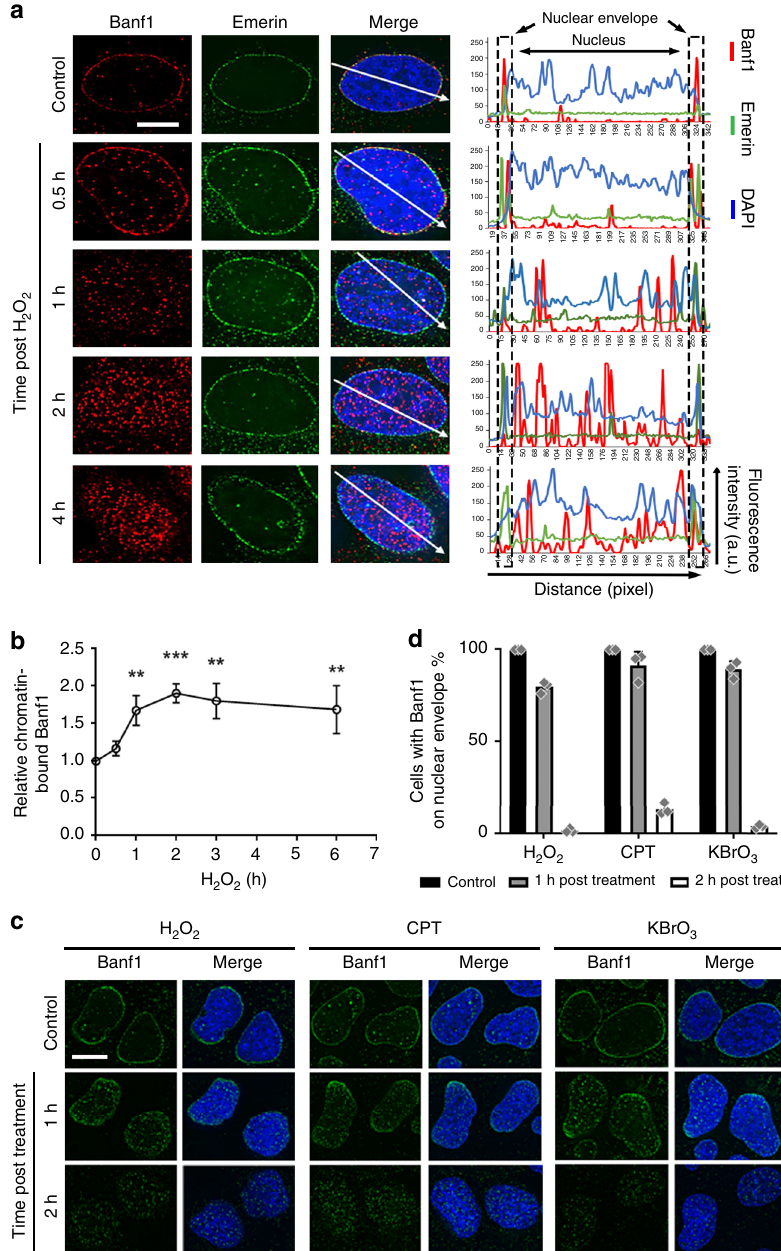
Fig. 1 Banf1 responds to oxidative stress. a Banf1 relocalises from the nuclear envelope following oxidative stress induced by 200 μ M H 2 O 2 in U2OS cells. Representative cells are shown. b The nuclear intensity of Banf1 in U2OS cells treated as in ( a ), were analysed via an InCell Analyser 2200. One-way ANOVA was used for statistical analysis. c Banf1 relocalisation following hydrogen peroxide (H 2 O 2 ), camptothecin (CPT), or potassium bromate (KBrO 3 ) at the indicated times post compound removal. Representative cells stained with the indicated antibodies are shown. d Nuclear envelope localisation (from ( c )) was assessed using a delta vision PDV microscope. Immuno fl uorescence scale bars represents 10 μ m. Histogram data shown represent the mean and S.D. of three independent experiments. ANOVA ** P < 0.01, *** P < 0.001. Source data are provided as a Source Data fi